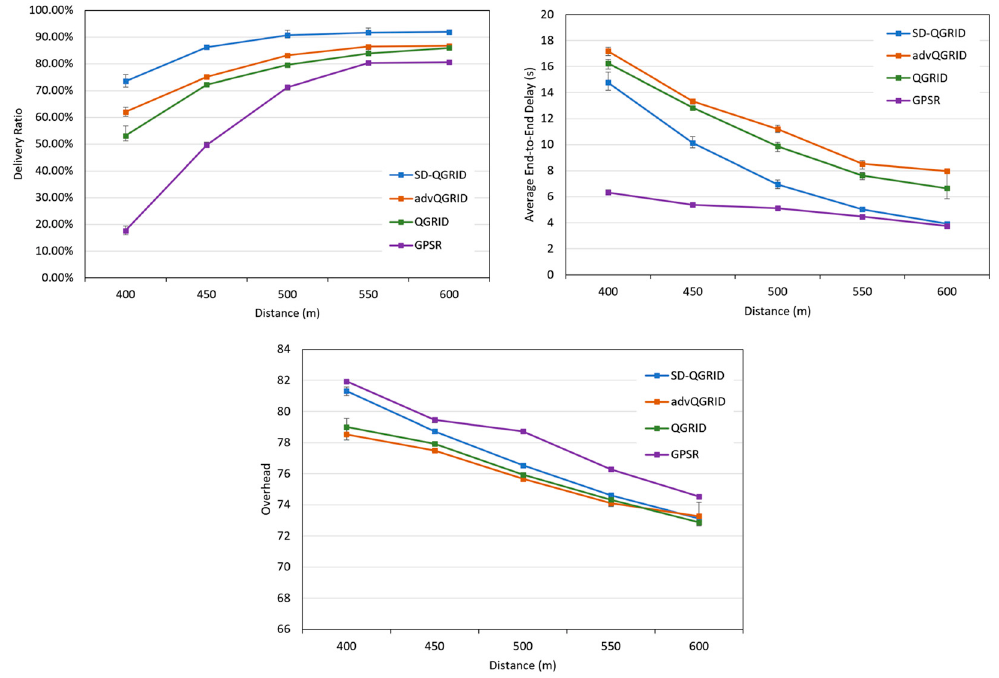
Figure 14. Simulation comparison among different routing protocols vs. different distances. Table 9. Performance improvement of SD-QGrid compared to routing protocols with distances.